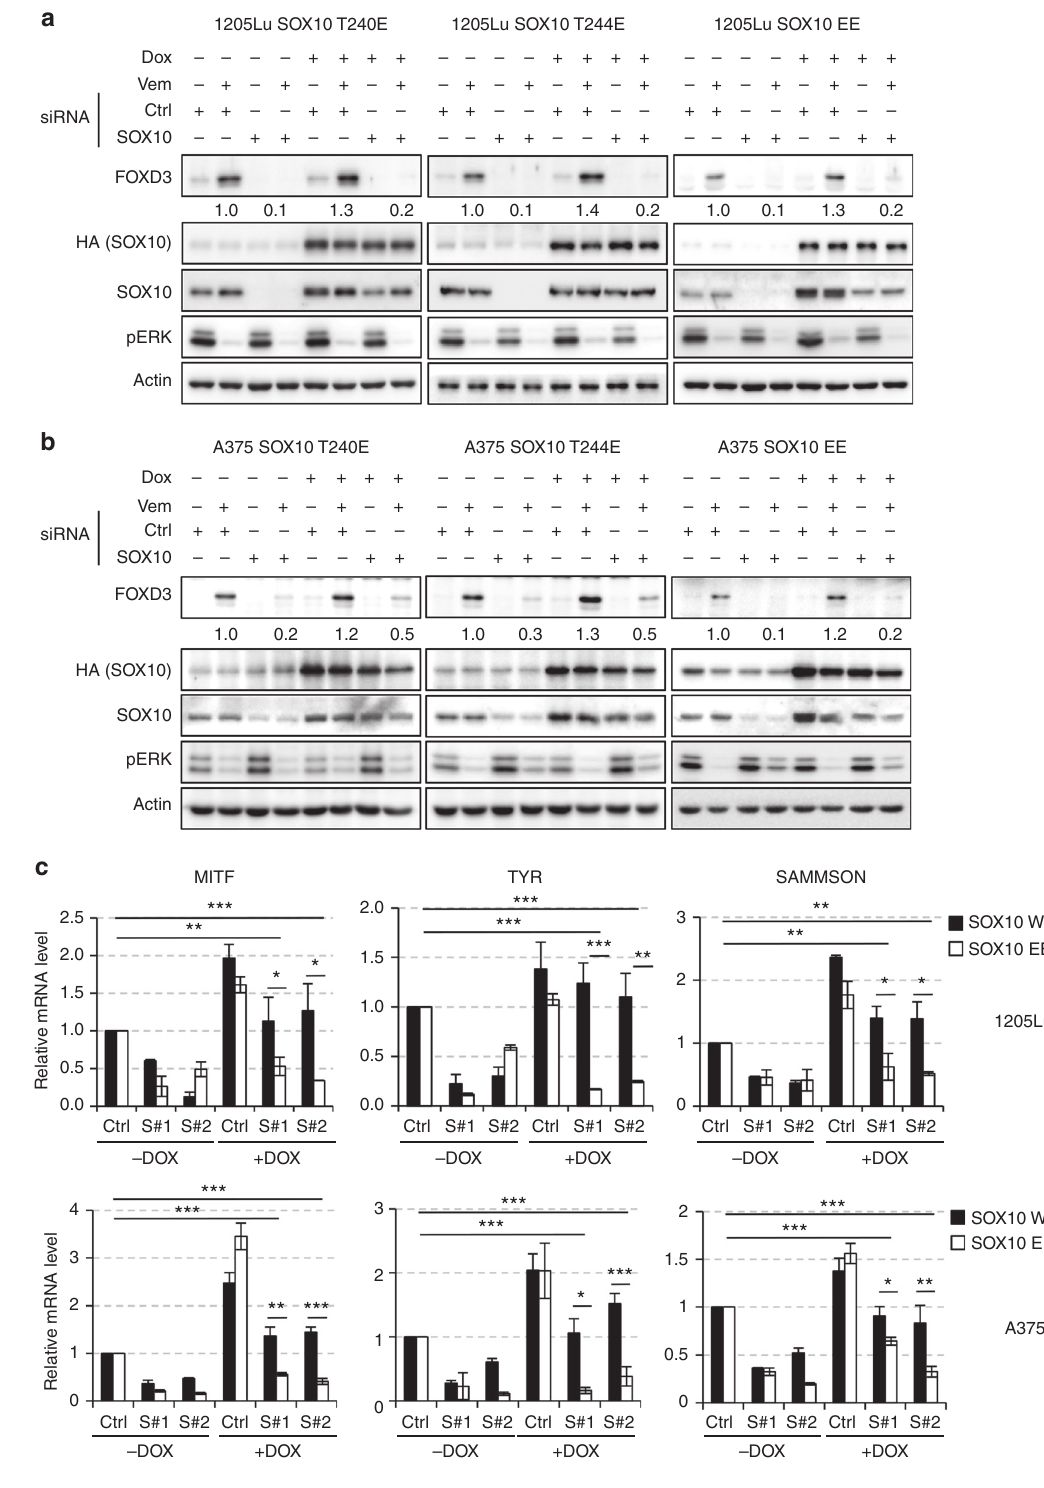
Fig. 4 Phosphorylation at T240 and/or T244 inhibits transcriptional activity of SOX10 toward FOXD3 and other targets. a 1205Lu-TR cells transduced with lentiviruses carrying siRNA-resistant, HA-tagged SOX10 cDNA variants including T240E, T244E, and EE were transfected with SOX10 siRNAs for 72 h in the absence or presence of 100 ng ml − 1 doxycycline. Cells were then lysed and analyzed by western blot on indicated proteins. Actin was used as a loading control. Quantitation of FOXD3 expression is shown below the corresponding blots. b Same as ( a ) except that A375-TR cells were used. c 1205Lu-TR (top) or A375-TR (bottom) cells transduced with either WT or EE HA-SOX10 lentiviruses were transfected with SOX10 siRNAs for 72 h with or without 100 ng ml – 1 doxycycline. Cells were then treated with 2 μ M Vemurafenib for 24 h and lysed for total RNA isolation and qRT-PCR analysis. Average results from three independent experiments are shown. Error bars represent standard deviation. Signi fi cance was determined by ANOVA one-way test,* p < 0.05; ** p < 0.01; *** p < 0.001. Uncropped images are shown in Supplementary Fig.